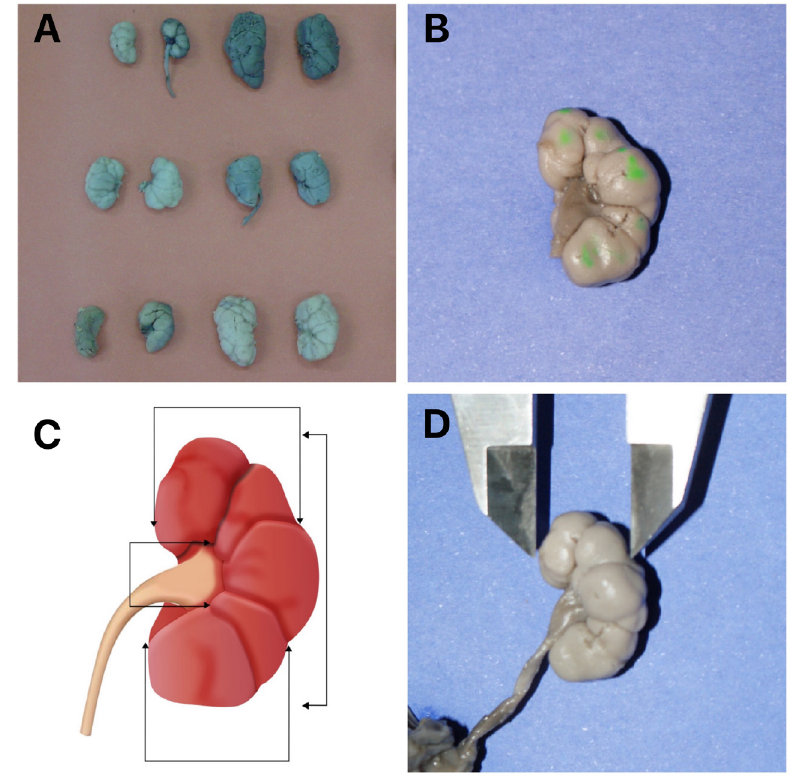
Figure 1 - Renal clefts and kidney